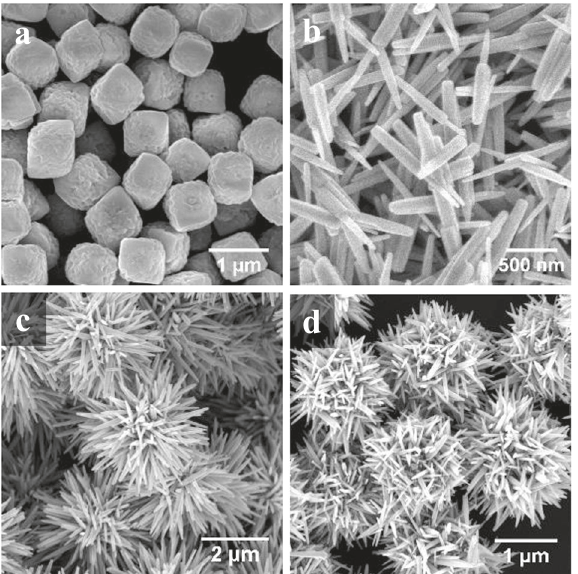
Fig. 1 | Hedgehog particle catalysts and component parts. SEM images of a hematite microcubes (Fe 2 O 3 MCs), b ZnO nanorods (ZnO NR), c 3.7-ZnO/Fe 2 O 3 hedgehog particles (HPs), and d 1.9-ZnO/Fe 2 O 3